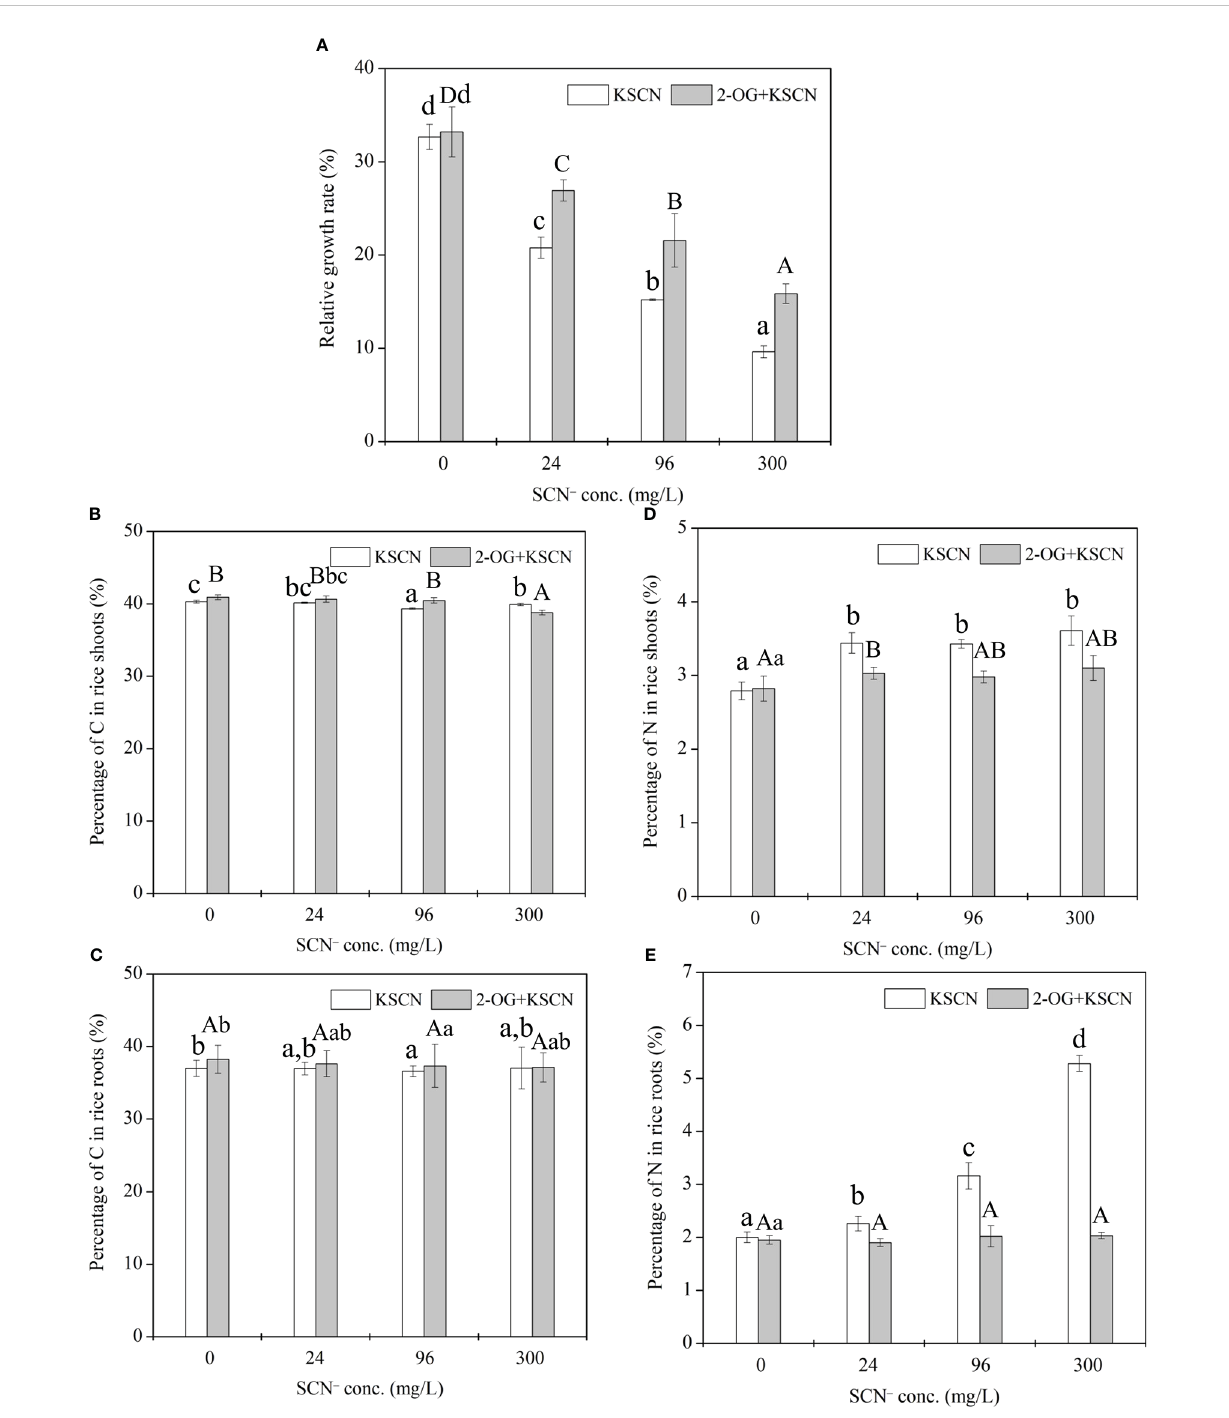
FIGURE 1 (A) Relative growth rate of rice seedlings under SCN − exposure in the presence or absence of 2-OG. (B) The percentage of C in rice shoots. (C) The percentage of C in rice roots. (D) The percentage of N in rice shoots. (E) The percentage of N in rice roots. Values are the mean of four independent biological replicates ± standard deviation. Different letters refer to the signi fi cant difference between treatment and control ( p < 0.05). 2-OG, 2-